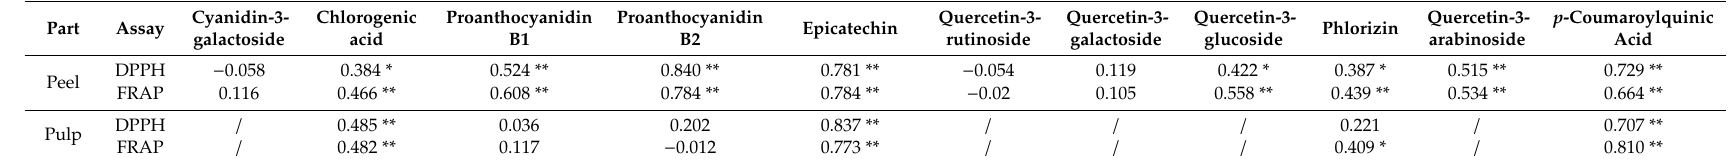
Table 5. Correlation analysis of phenolics content and antioxidant